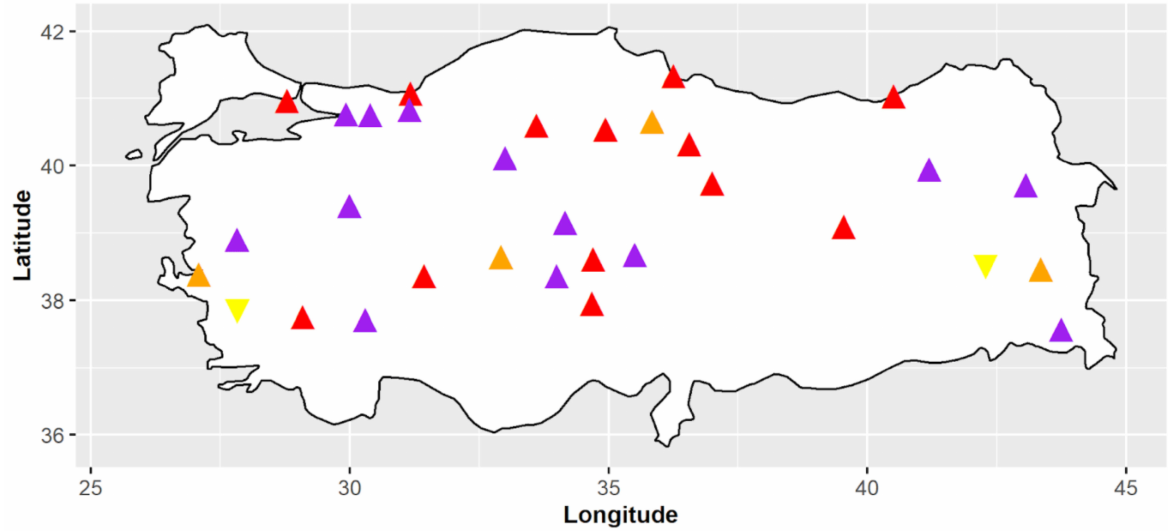
Figure 9. Mann-Kendall trend results of TCI values for autumn (See Figure 6 for